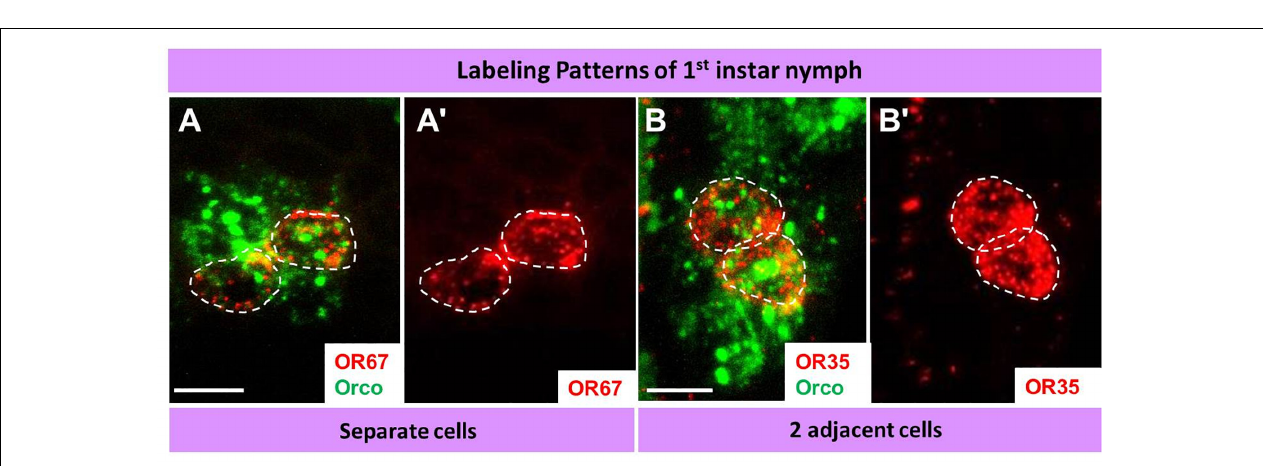
FIGURE 7 | During late development (5th instar nymph) distinct OR types are expressed in multiple cells basiconic sensilla. In A–D’ cells expressing a distinct OR type and Orco were visualized by means of two-color FISH using specific antisense riboprobes. The analyses of 10 µ m optical stacks from sections of 5th instar nymph antennae revealed four different patterns of OR expression, similar to adults. White dash circles outline distinct OR cells. Scale bar, 10 µ m.